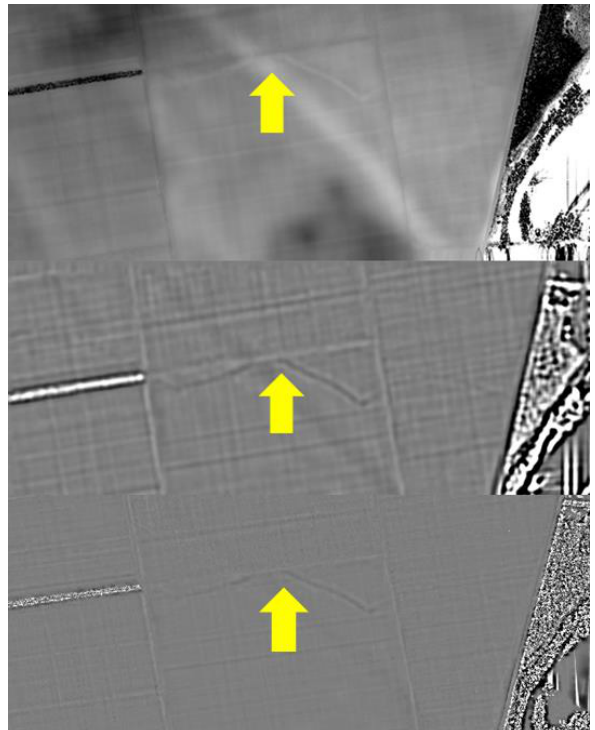
Figure 6. Anti-tank trench identification with Kriging (top), using Laplace filter (middle) and Local Relief Model (bottom)